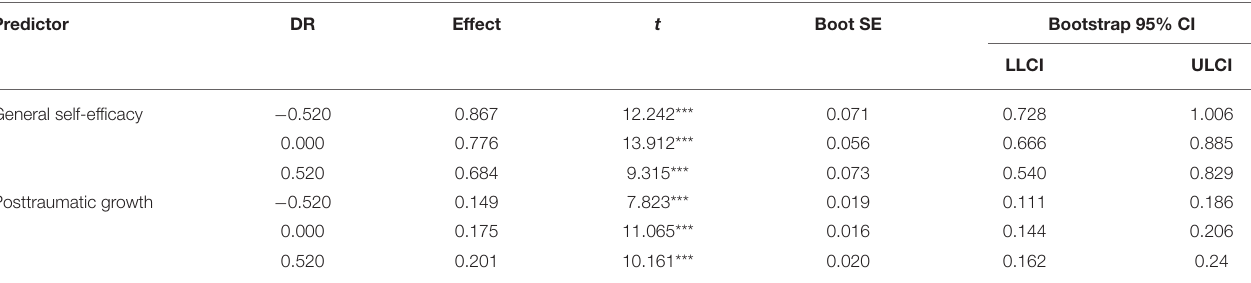
TABLE 5 | The mediating response value of independent variables GSE and PTG at different levels of the modulating variable DR ( N = 881). Predictor